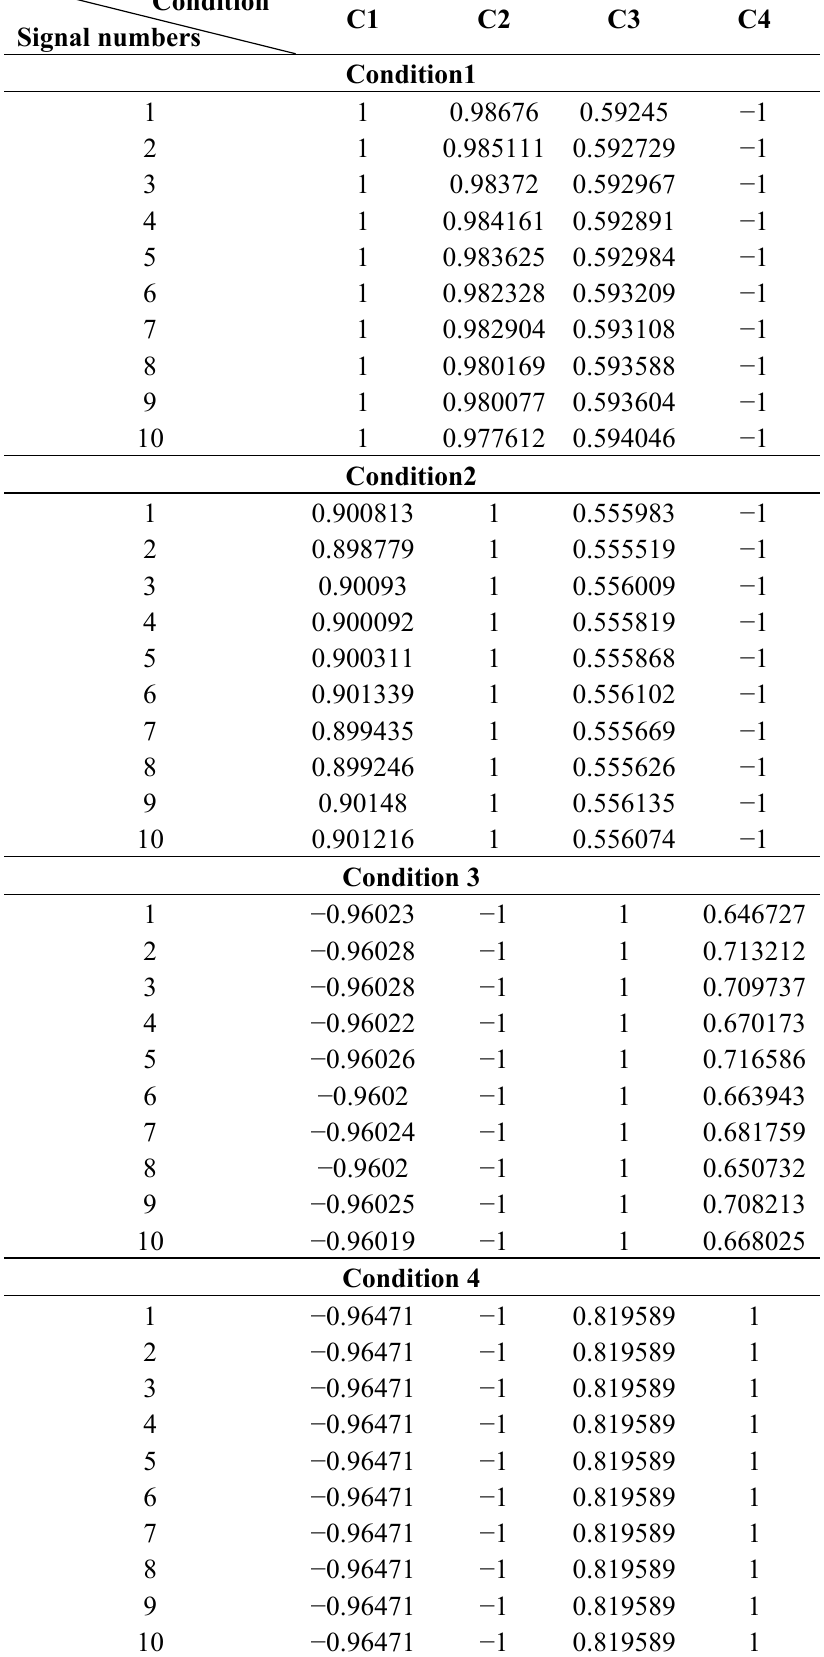
Table 1. Blade state diagnostic experimental